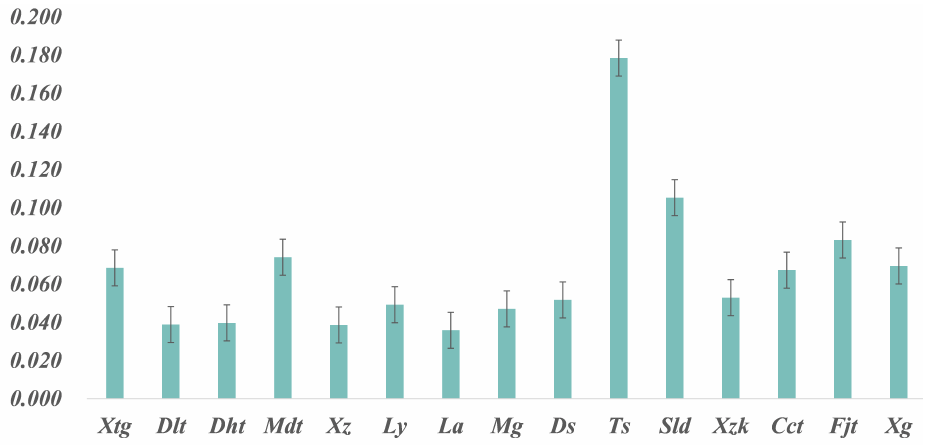
Figure 5. Evaluation score results